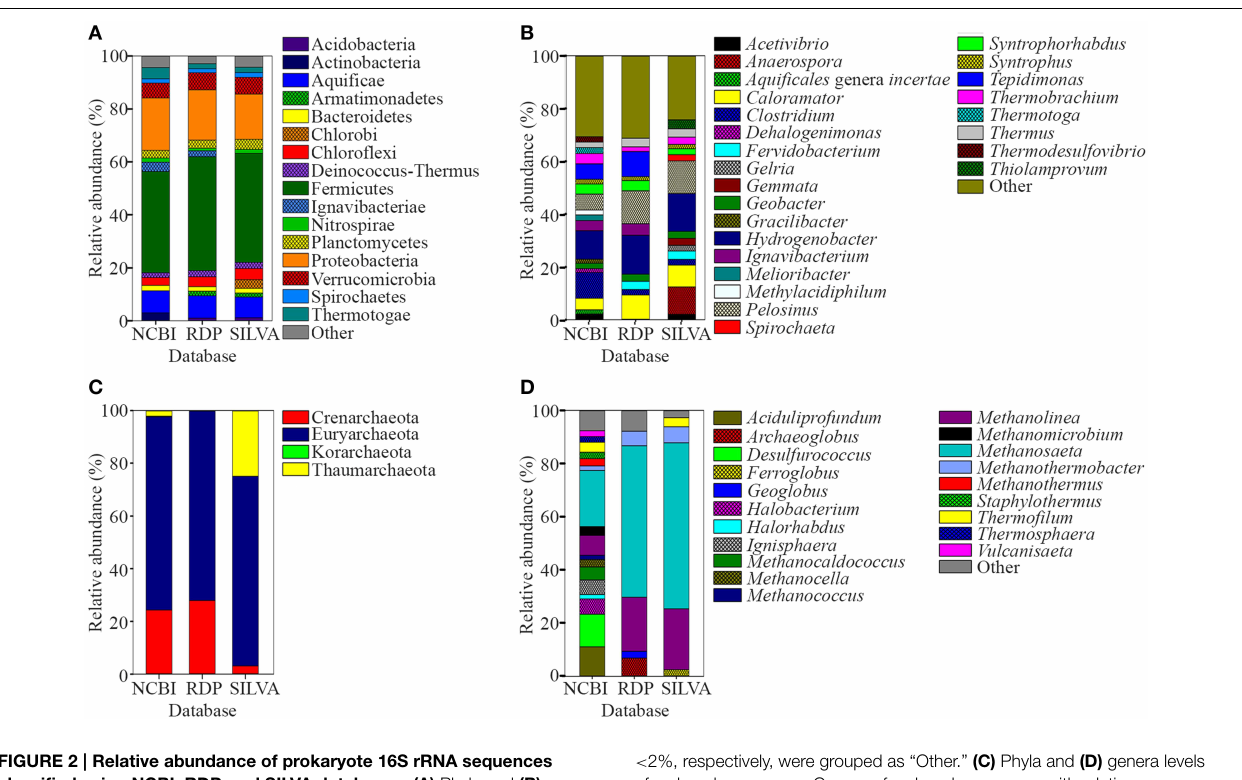
FIGURE 2 | Relative abundance of prokaryote 16S rRNA sequences classified using NCBI, RDP, and SILVA databases. (A) Phyla and (B) genera levels of prokaryote sequences with relative abundances of < 1 and